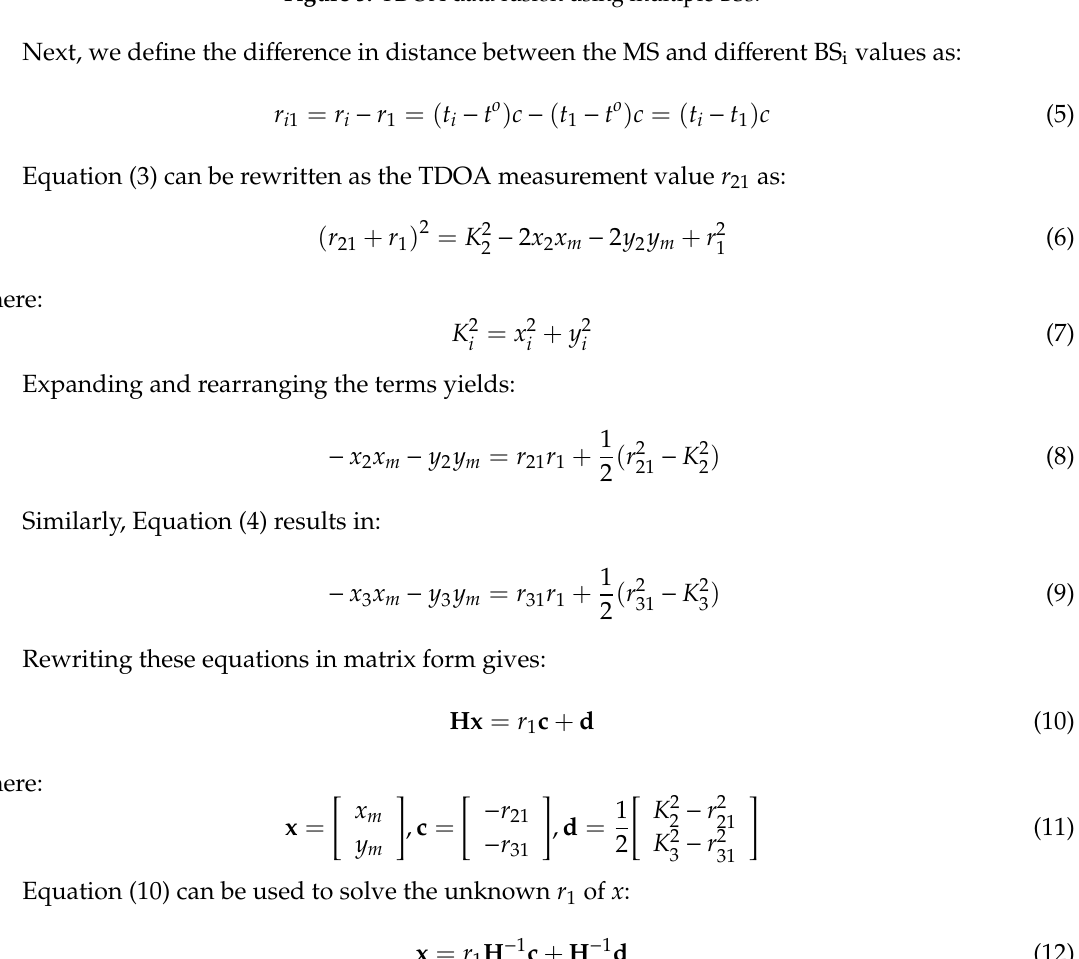
Figure 5. TDOA data fusion using multiple BSs.